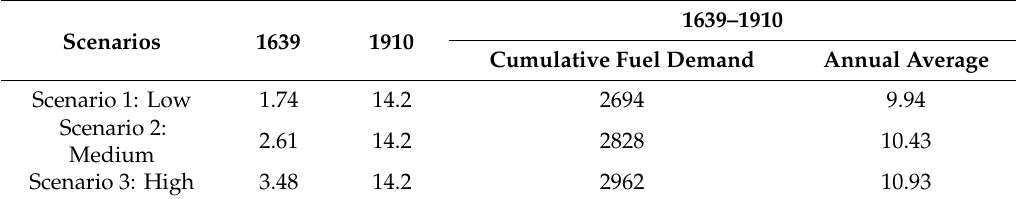
Table 2. Fuelwood demand by scenario (unit: million m 3 ).